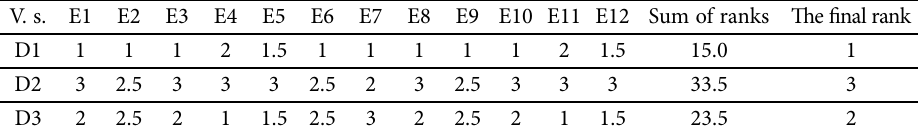
Table 5. Ranking factors in the group of a competitive environment regarding the commercial potential of technologies